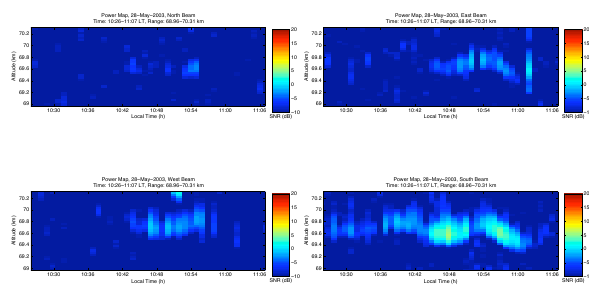
Fig. 18. SNR map in all four beams of event at 66.5 km on May 27, 2003 at 10:00 LT.